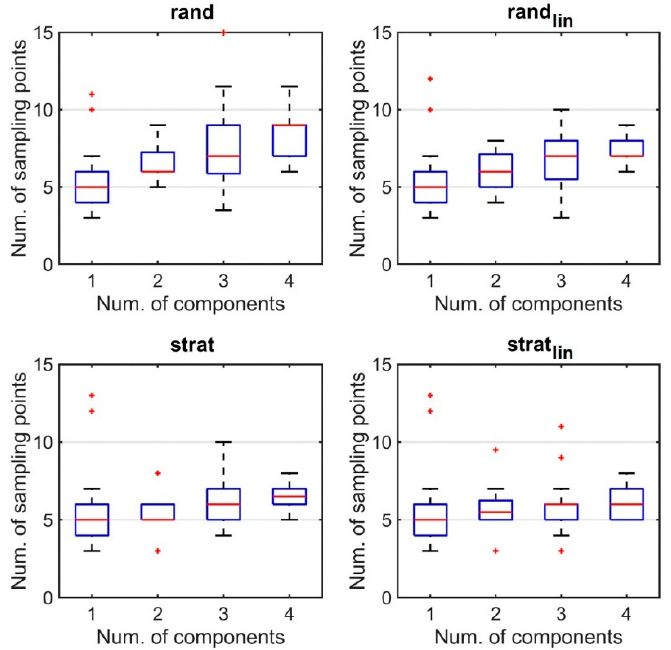
Figure 8. Box plot of the 95th percentile of the number of sampling points needed to meet the T10 thresholds for all the FLEX pixels in both sites. Groups “1”, “2”, “3” and “4” represent FLEX pixels with the corresponding number of land cover components.